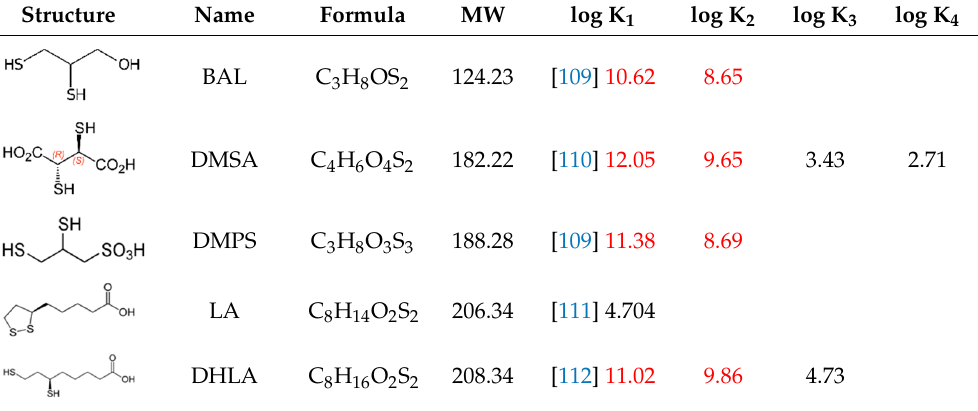
Table 1. Protonation constants of BAL, DMSA, DMPS, lipoic acid (LA), and dihydrolipoic acid (DHLA). Structure